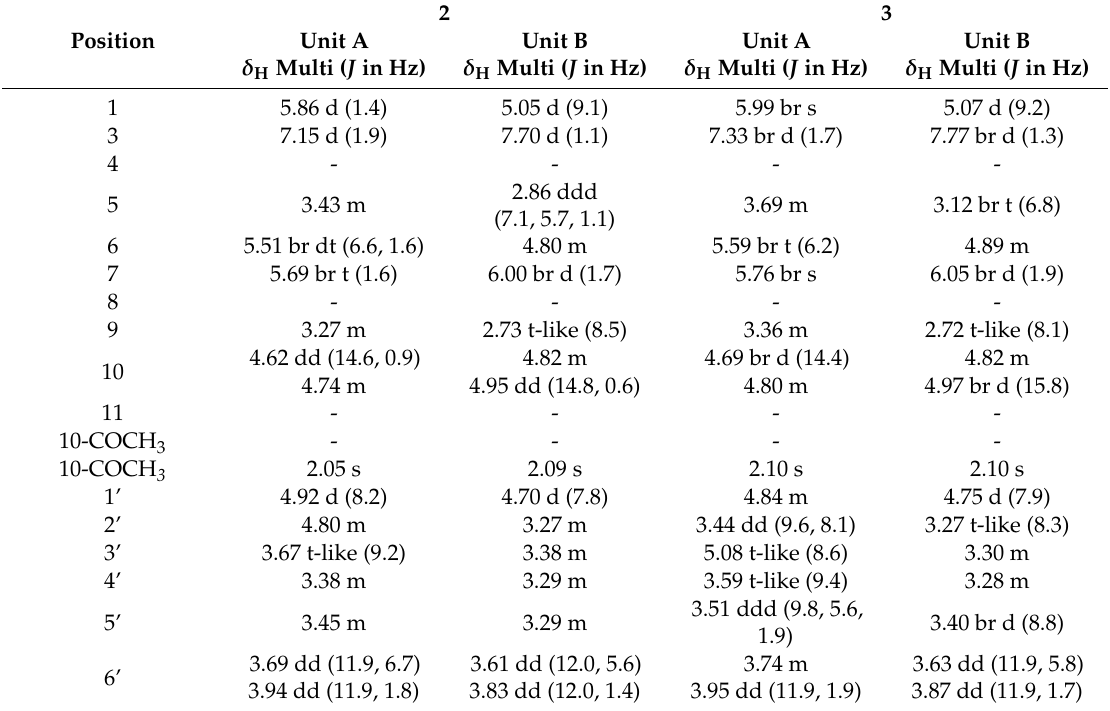
Table 2. 1 H-NMR data of compounds 2 – 3 (500 MHz, CD 3 OD, δ in ppm, J in